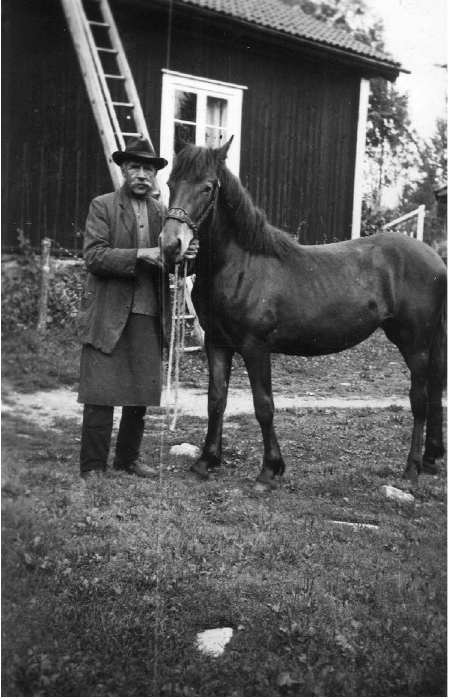
Figure 5. Rällsjö Anders Jansson (1863–1951) used masterwort in a remedy for horses called ‘Kampkur’ (horse remedy). Many plants from his garden in Dalecarlia are preserved in the Swedish National Gene Bank (Photo from private collection).